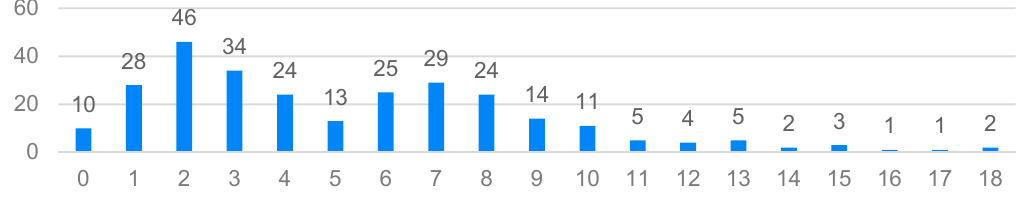
Figure 2. Distribution of the HADS depression scores.